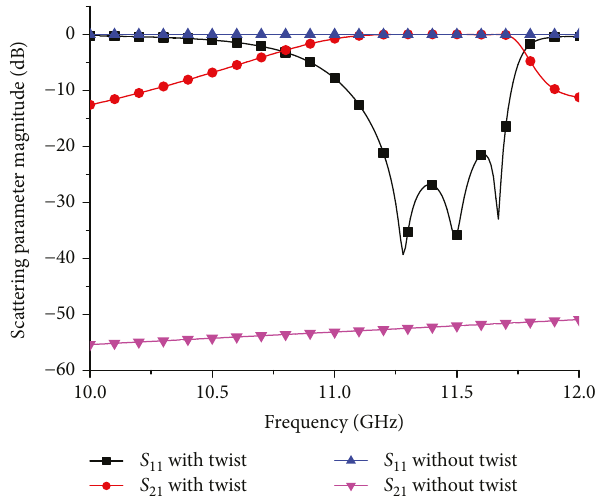
Figure 4: The optimized S parameters with and without the waveguide